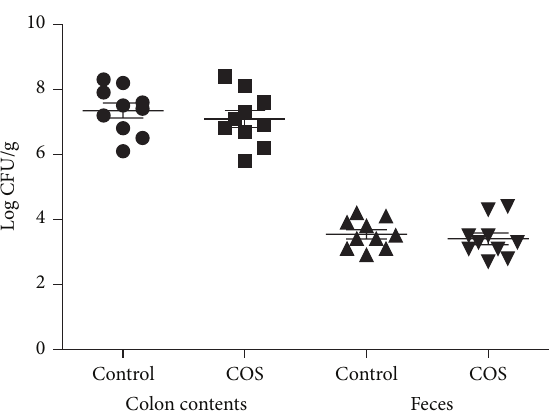
Figure 1: D7 postinfection C. rodentium levels in colon contents and feces of infected C57BL/6 mice. Feces and colon contents were gathered before undergoing homogenisation and being plated in serial dilution on LB agar ( 𝑛 = 10 ).